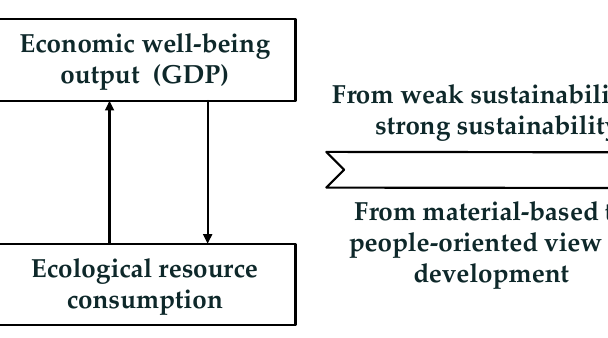
Figure 1. From eco-efficiency to ecological well-being performance analysis framework.